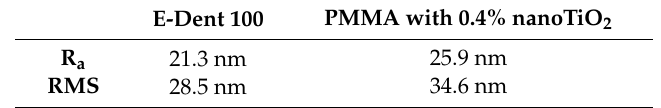
Table 2. Statistical quantities calculated for the 2D topography image (5 × 5 µ m).